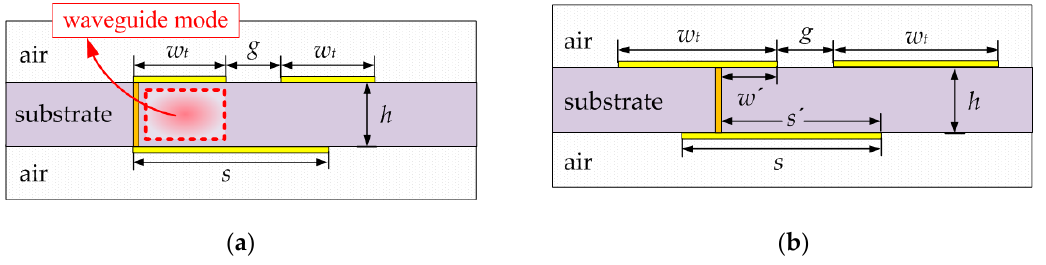
Figure 4. Cross-sectional analysis model: ( a ) the microstrip-to- coplanar stripline (CPS) transition [15]; ( b ) the proposed microstrip-to-slotline transition.